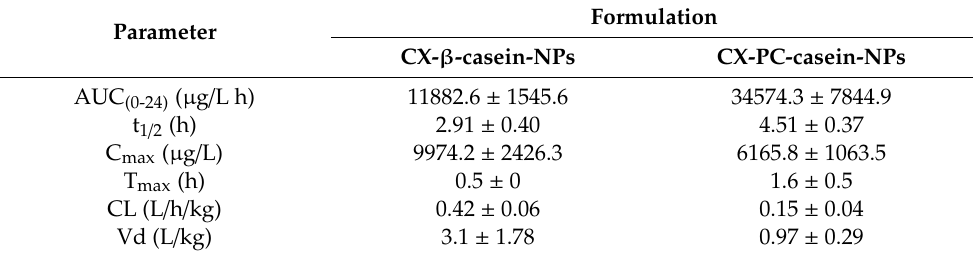
Figure 5. Concentration–time curve following 5 mg / kg CX b.wt. with two nano-formulations, administered via the caudal vein ( n = 5). Data are presented as the mean ± standard deviation. Table 2. Pharmacokinetic parameters for CX- β -casein-NPs and CX-PC-casein-NPs.